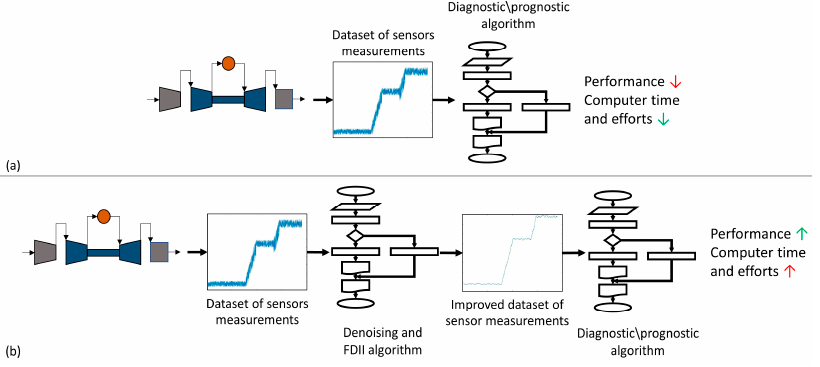
Figure 9. Difference between two approaches: ( a ) Diagnostic/prognostic algorithm informed with pure sensor measurements; ( b ) Diagnostic/prognostic algorithm informed with improved sensor measurements.